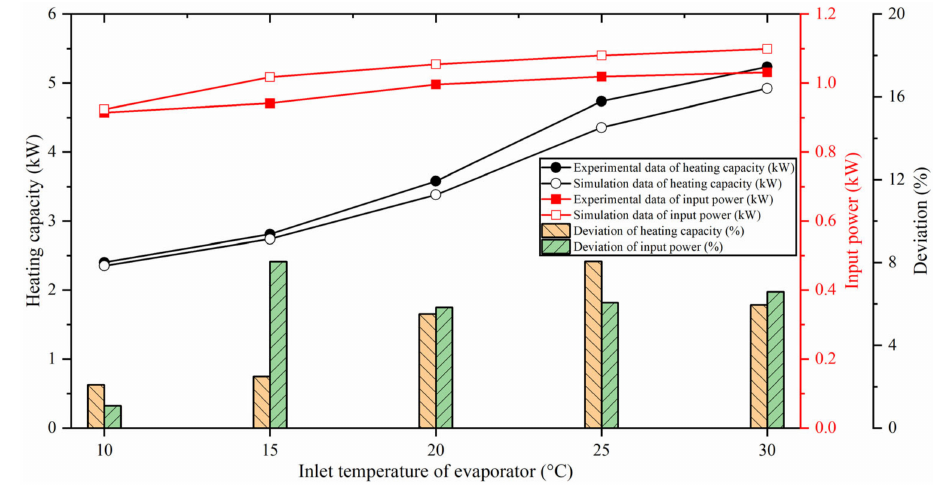
Figure 8. Comparison of simulation and reference results of